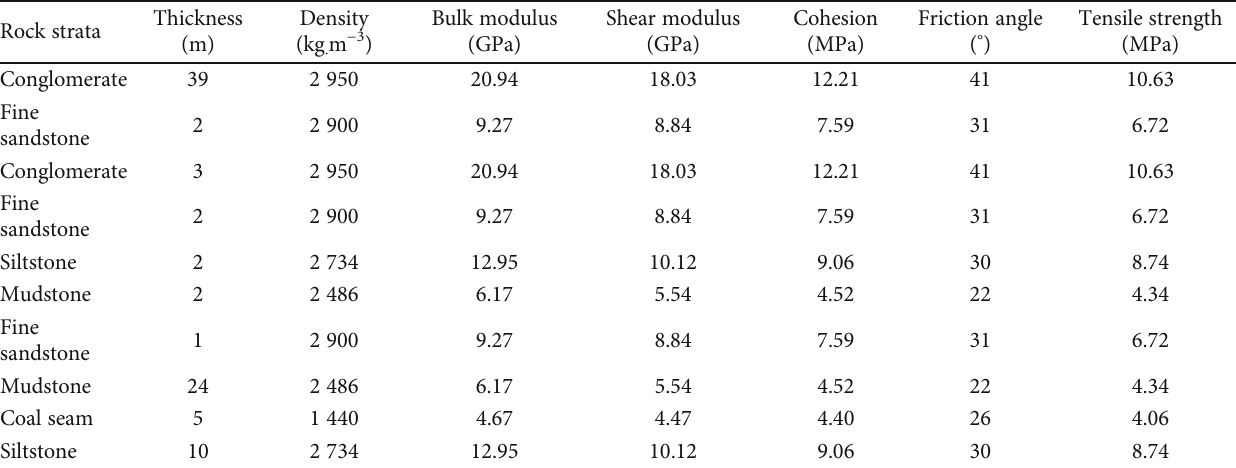
Figure 11: Numerical model of the extra-thick roof in FLAC 3D . Table 5: Physical and mechanical parameters of rock strata in the FLAC 3D